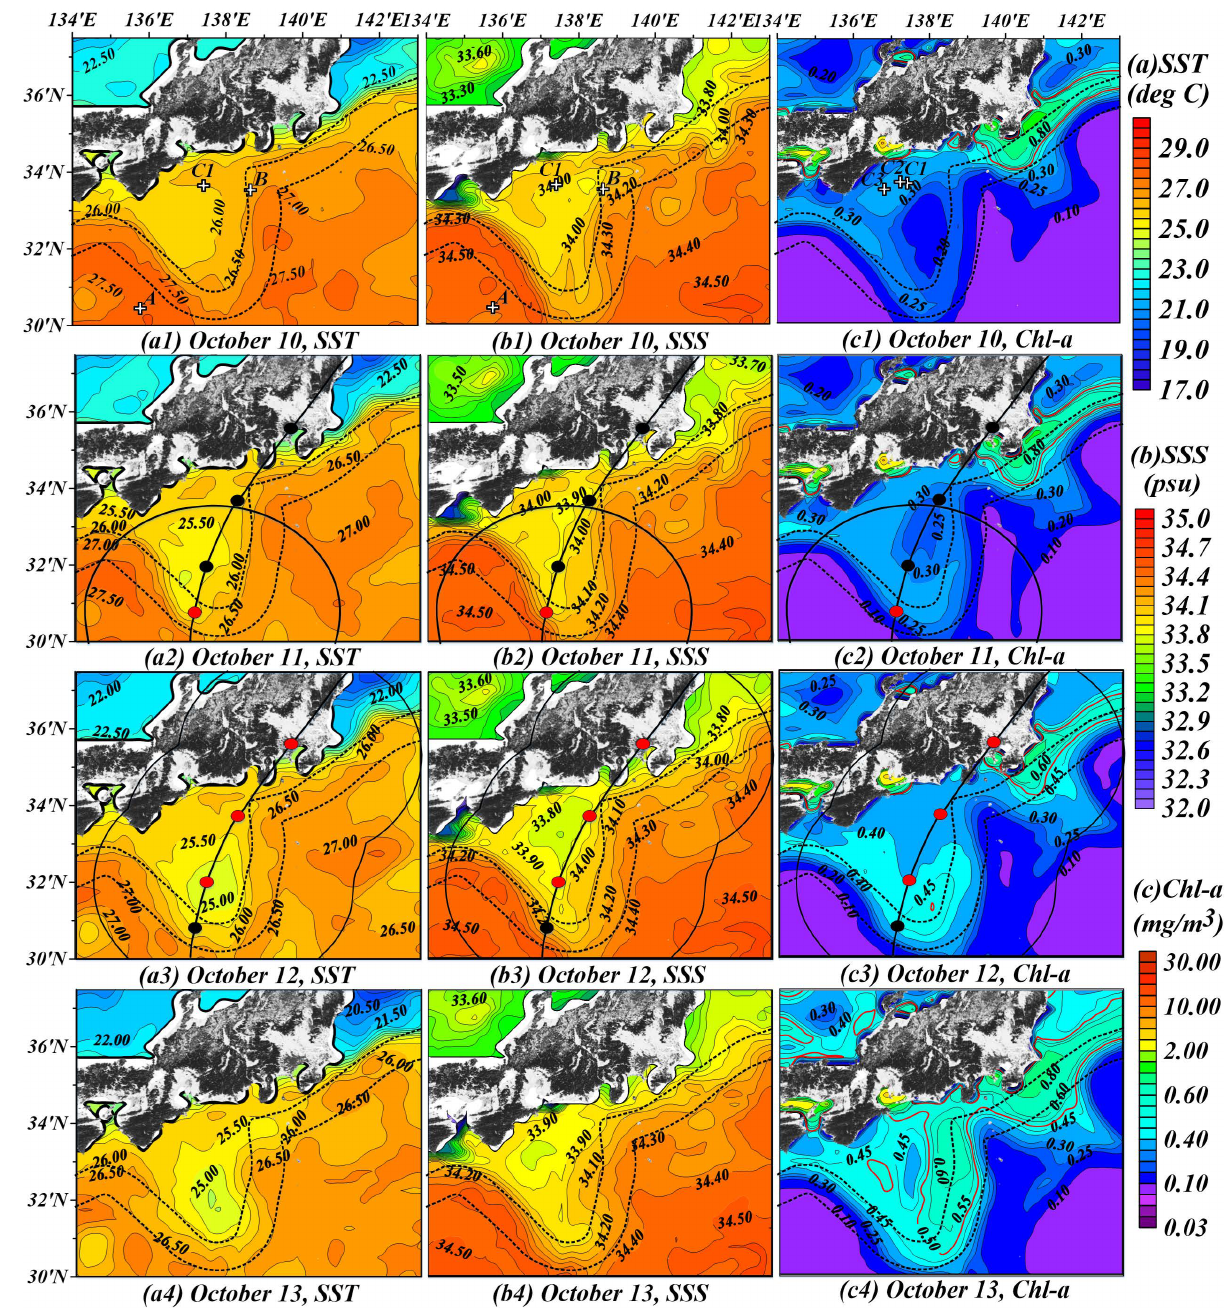
Figure 8. Daily sea surface temperature (SST), salinity (SSS), and chlorophyll a (Chl-a); on 10 October ( a1 , b1 , c1 ), 11 October ( a2 , b2 , c2 ), 12 October ( a3 , b3 , c3 ), and 13 October ( a4 , b4 , c4 ), re- spectively. Black dotted line, black line, and red dotted denote the Kuroshio meander provided by JCC, the storm wind zone, and the typhoon central location according to date. Solid red lines in all column c ( c1 – c4 ) indicate a boundary of high Chl-a is over 0.5 mg/m 3 . Physical Argo floats (ST and SS) are shown in points A and B, while a biogeochemical Argo float (ST, SS, DO, nitrate, and Chl-a) is shown in points C1, C2, and C3 according to